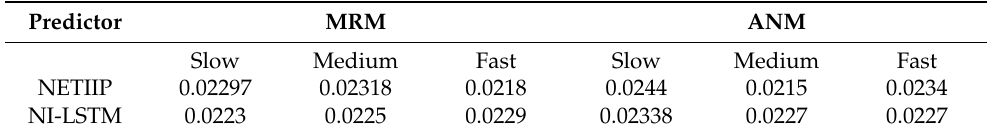
Table 6. Average time consumption. Predictor